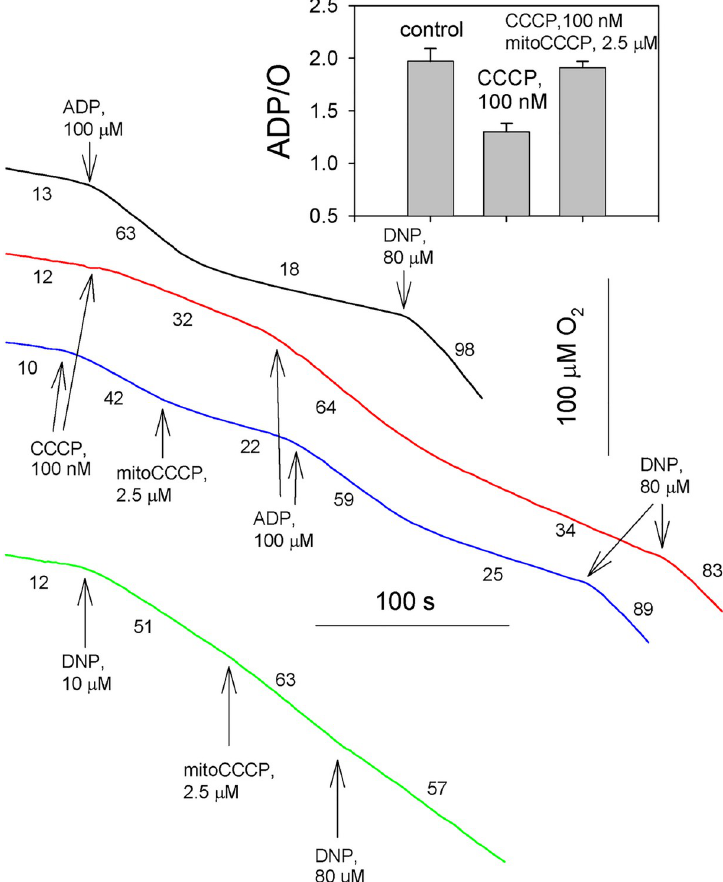
Fig 3. Effect of mitoCCCP (2.5 μ M) on the stimulation of succinate-driven respiration of rat liver mitochondria by CCCP (100 nM, blue curve) or by DNP (10 μ M, green curve). The three top traces show the stimulation of respiration by 100 μ M ADP due to ATP synthesis. Insert: Recoupling effect of mitoCCCP on the ADP/O ratio (amount of ADP phosphorylated/O atom consumed). Shown are Mean ± S.D. (n = 4). For experimental conditions, see Materials and Methods.